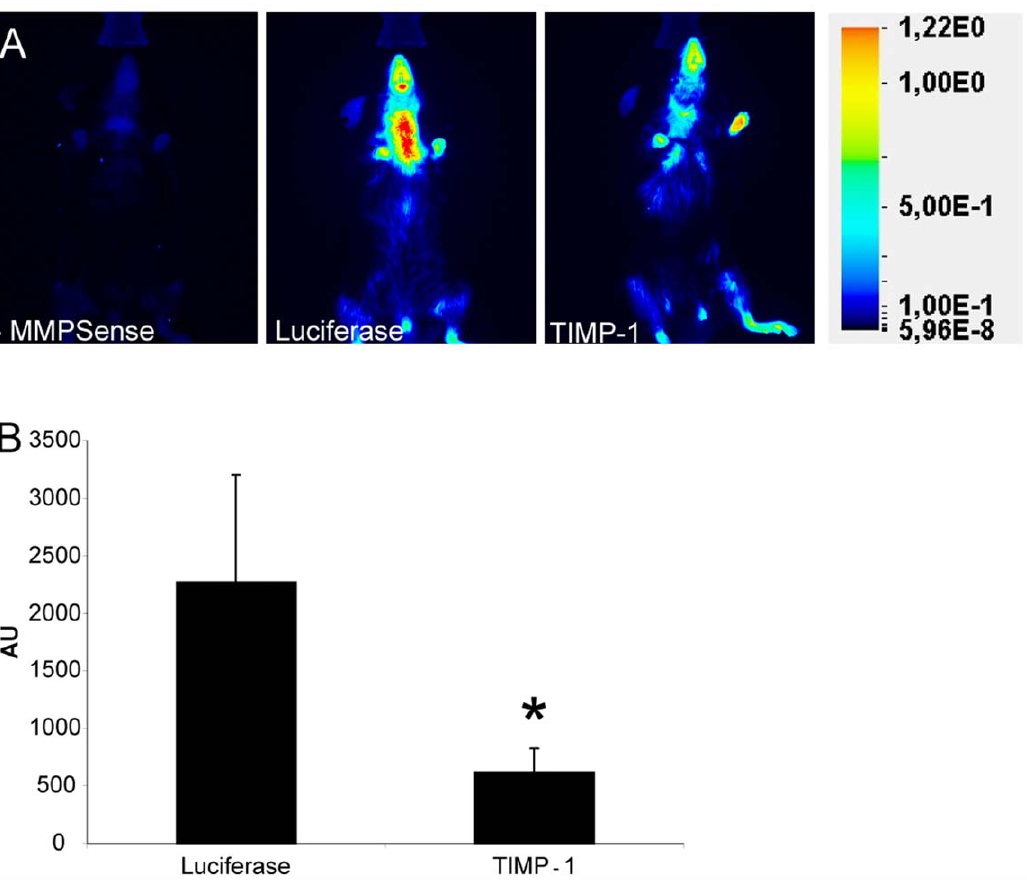
Figure 5. In vivo MMP activity in mice A; Representative Near-InfraRed-Fluorescence images of enzymatic MMP activity in mice. No signal was detected in mice without MMPSense. B ; Quantification of the MMP activity in the vein graft region (n=5/group).